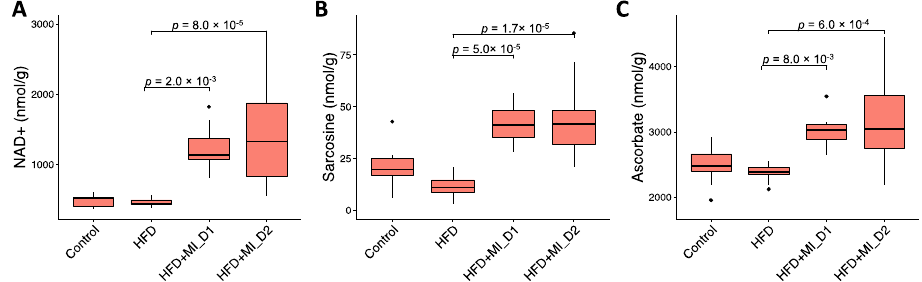
Figure 4. Hepatic concentration (nmol/g) of key metabolites modulated by CMA. (A) NAD + hepatic levels; (B) sarcosine hepatic levels; (C) ascorbate hepatic levels. Statistical differences were obtained levels; ( B ) sarcosine hepatic levels; ( C ) ascorbate hepatic levels. Statistical differences were obtained by one-way ANOVA followed by Tukey’s post-hoc test. by one-way ANOVA followed by Tukey’s post-hoc